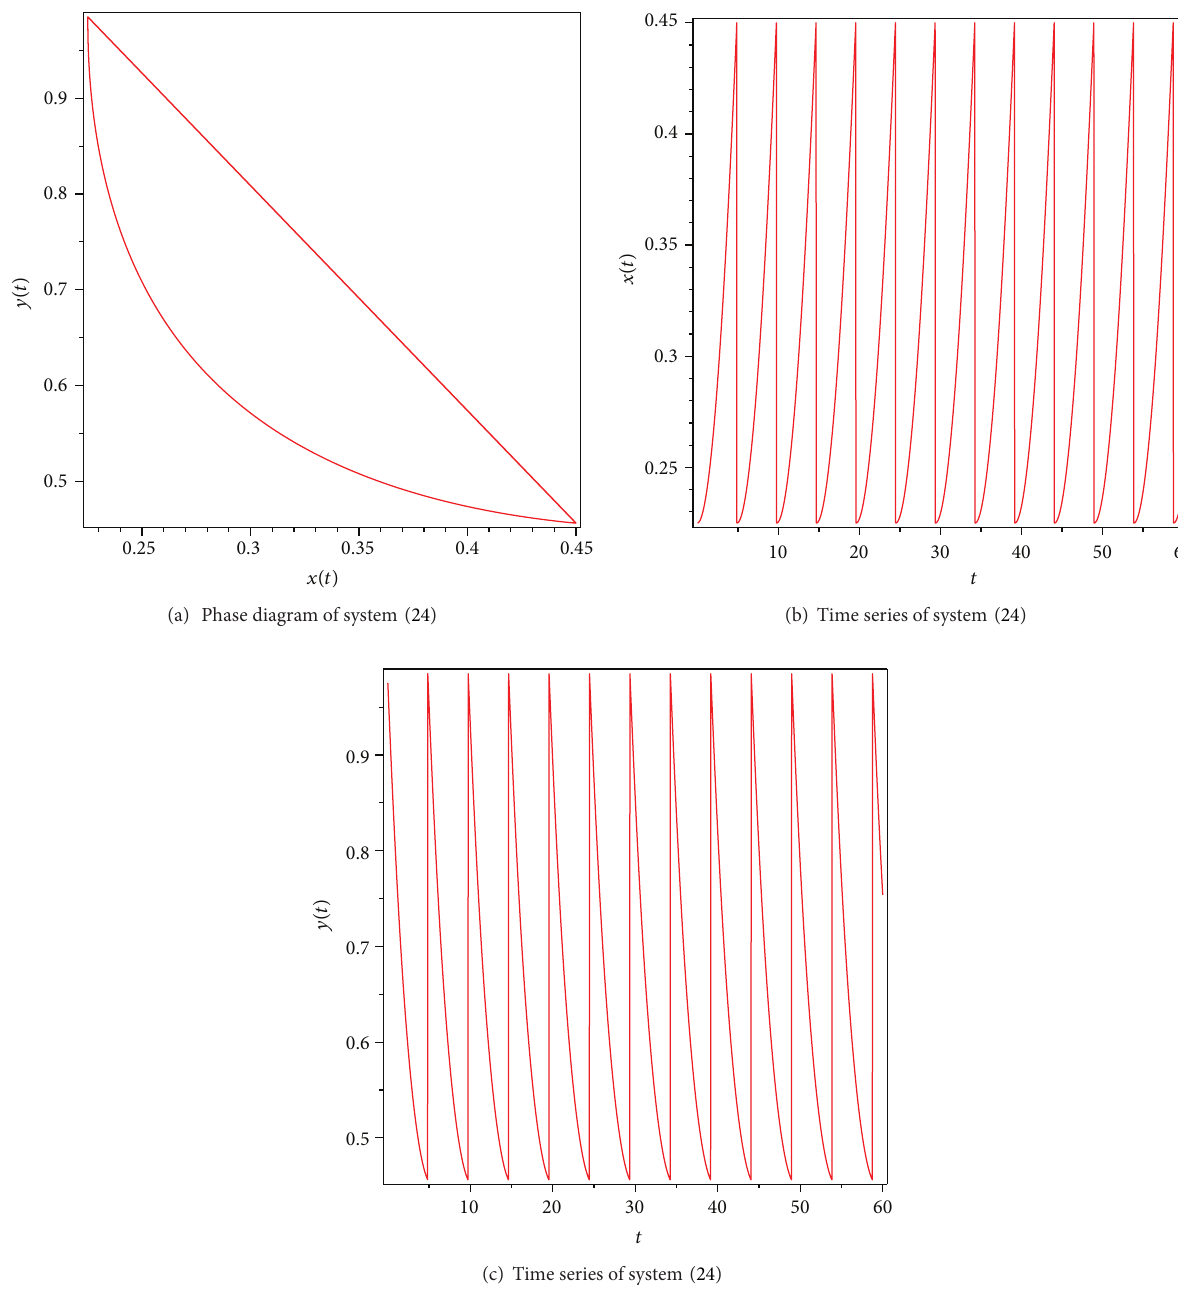
Figure 22: Illustration of basic behavior of system